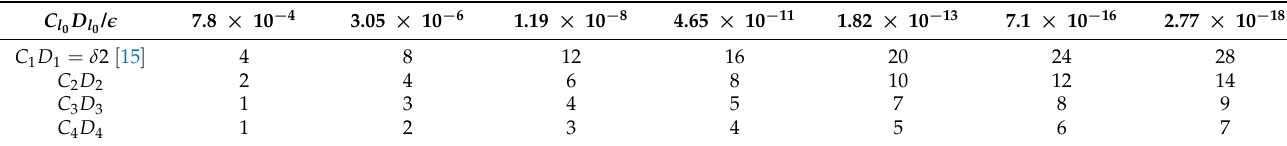
Table 6. Depth of the 3-point approximating QSS surface model.